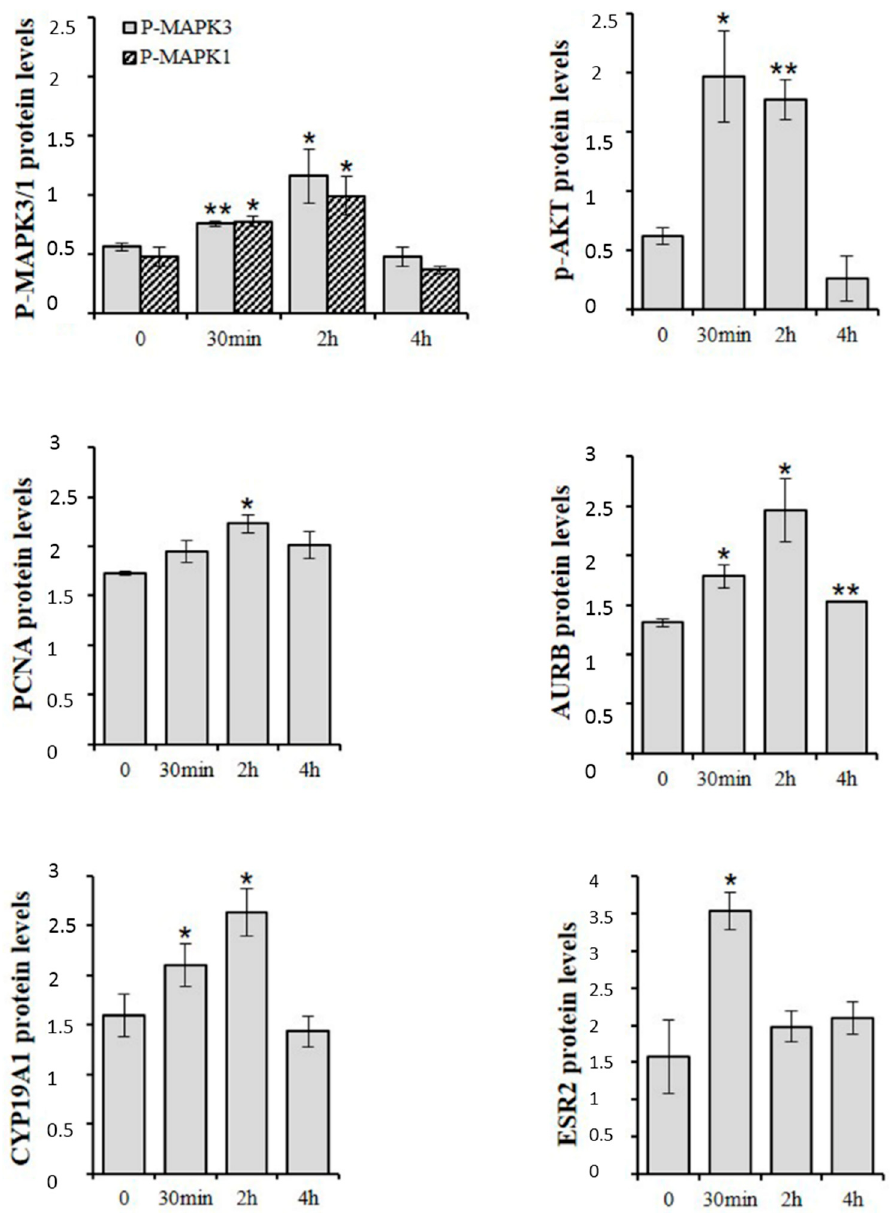
Figure 4. Western blot analysis of P-MAPK3/1, P-AKT, PCNA, AURKB, CYP19A1 and ESR2 in spermatogonial GC-1 cells at various times of D -Asp-treatment. Values represent the mean ± SD of three separate experiments. * p < 0.05 and ** p < 0.01 versus controls.